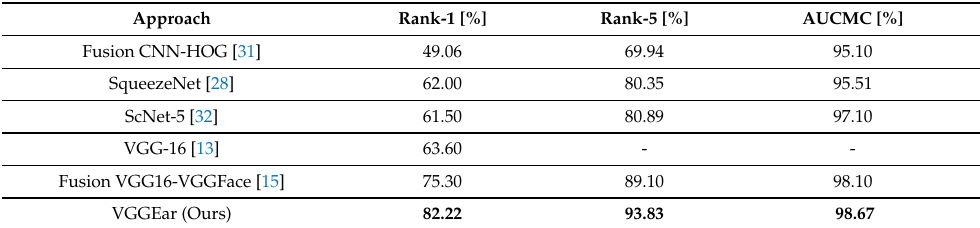
Table 8. Comparative evaluation with methods in the state-of-the-art over the UERC dataset test set. Bold values indicate the best performance of all different approaches for each